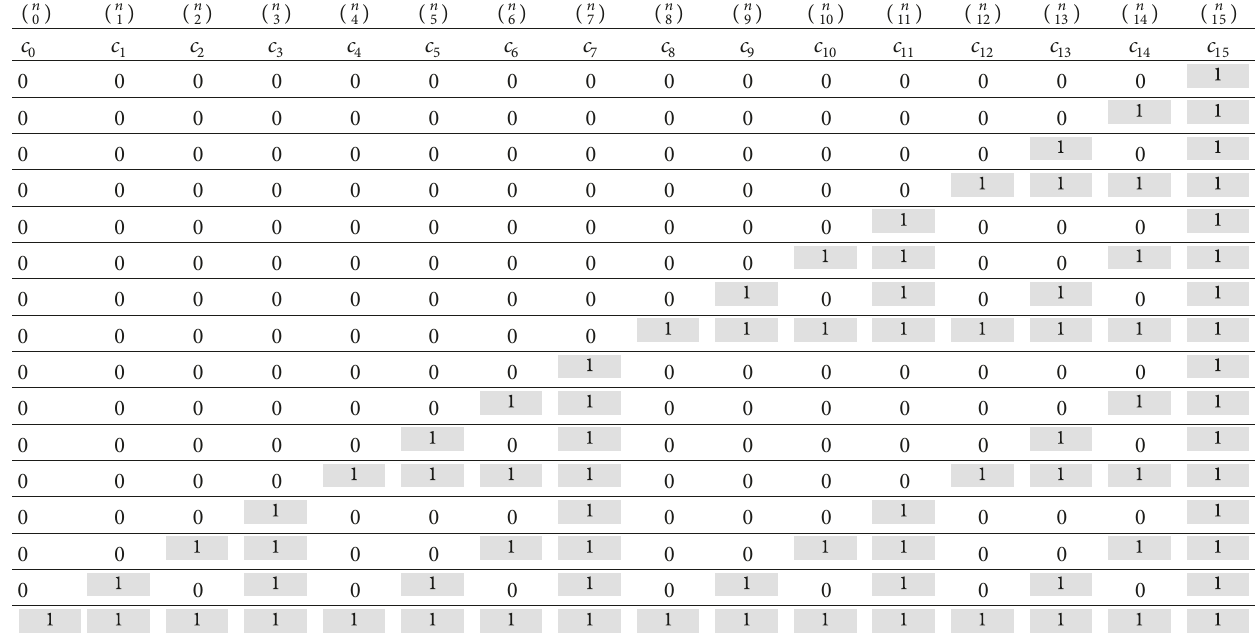
Table 3: Binomial representations of the 16 shifted versions of {( 𝑛 15 )}